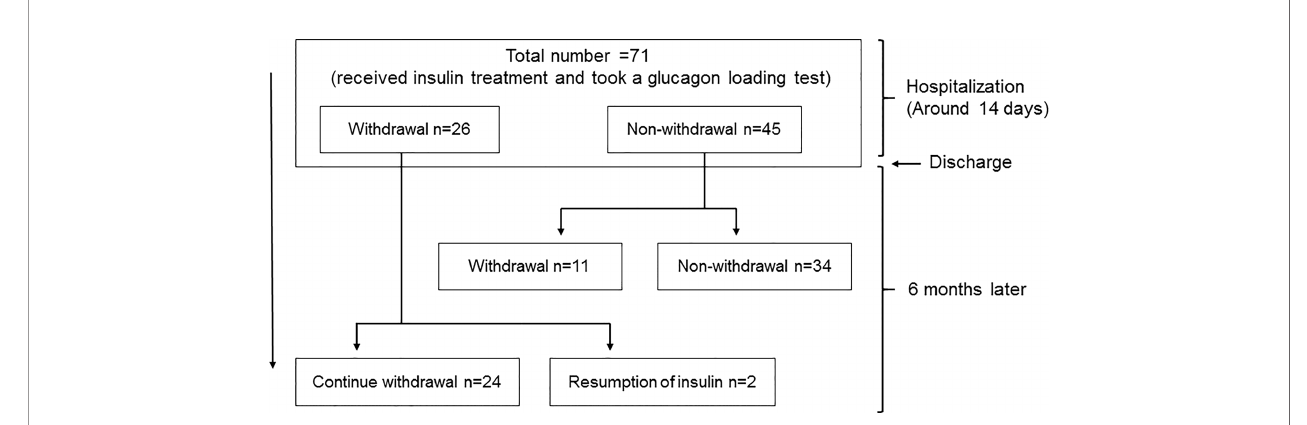
withdrawal was analyzed using logistic analysis. Statistical software was Excel Statistics for Mac version 16.54 (Social